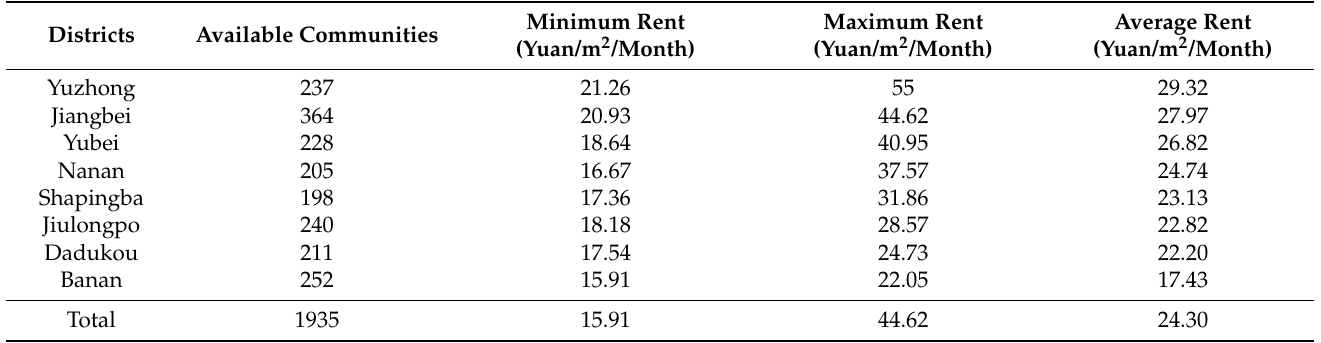
Table 4. Statistics of private housing rental prices in eight central districts of